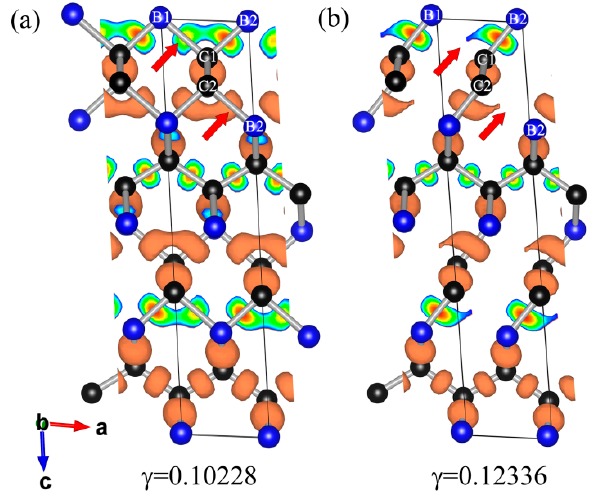
Figure 5. Developments of ELF for t- BC 2 during shear in the (110)[001] slip before ( a ) and after ( b ) shear instability.